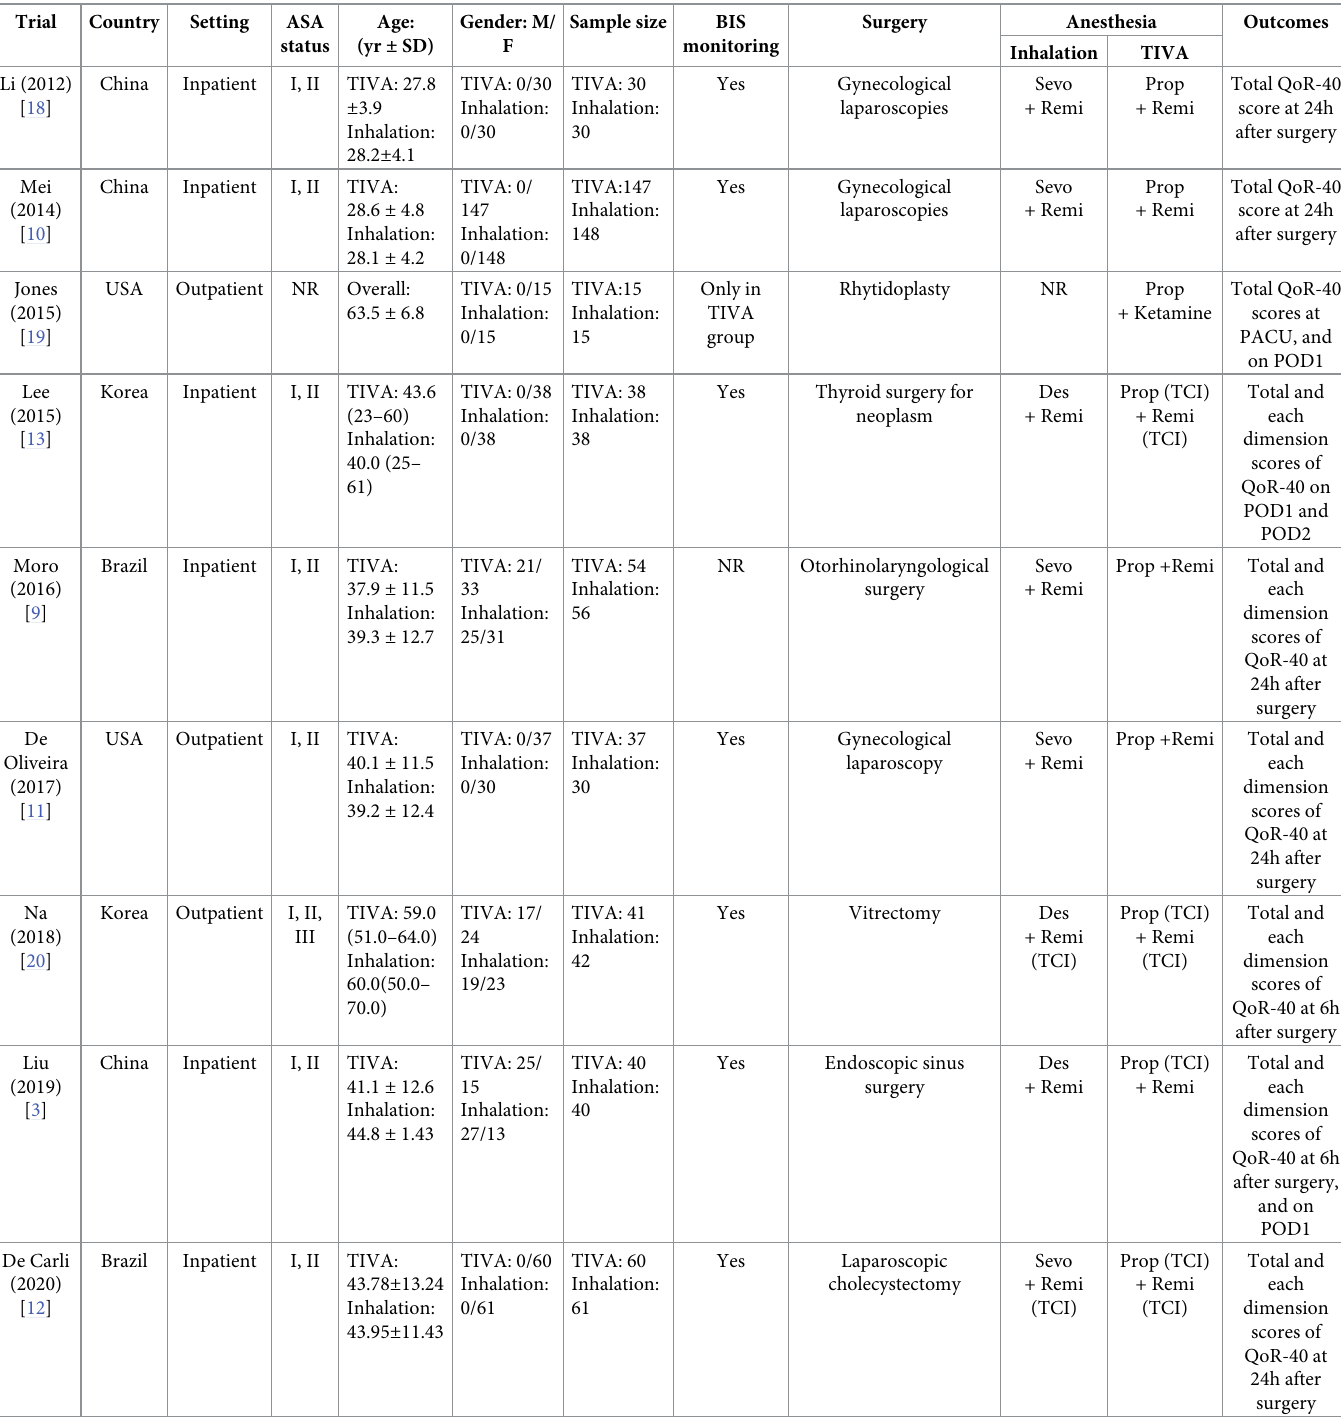
Table 1. Characteristics of included